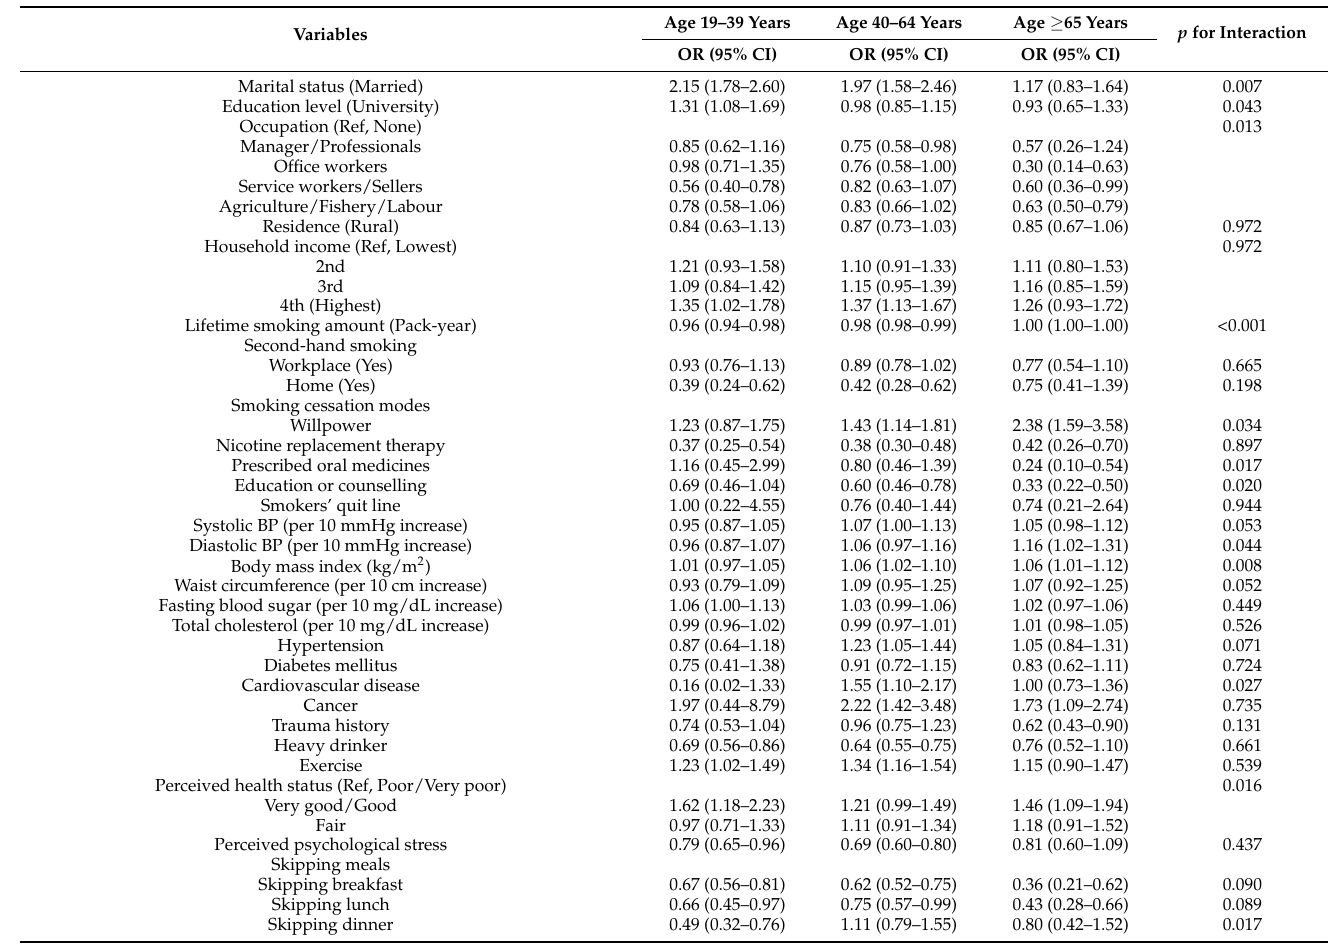
Table 4. Factors associated with smoking cessation by age